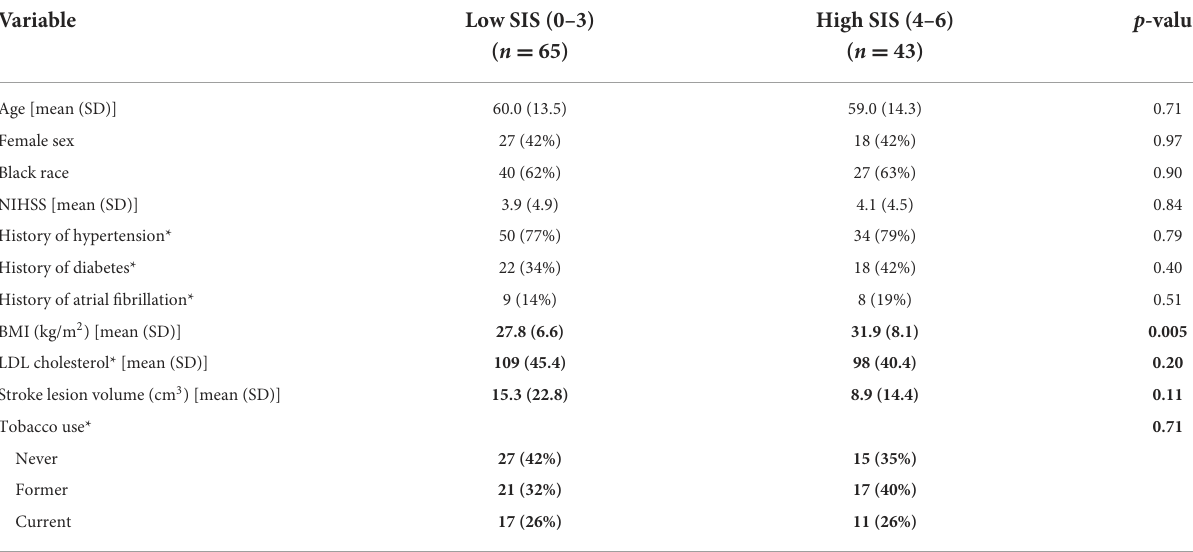
TABLE 1 Ischemic stroke patient demographic